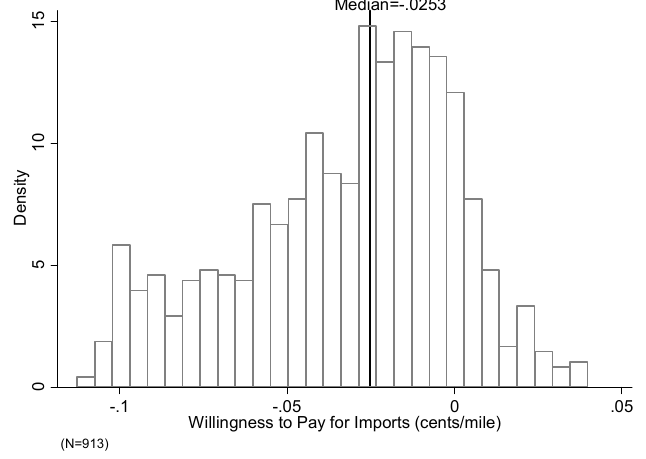
Figure 2. Estimates of Individual Willingness to Pay for Import Levels ( WTP